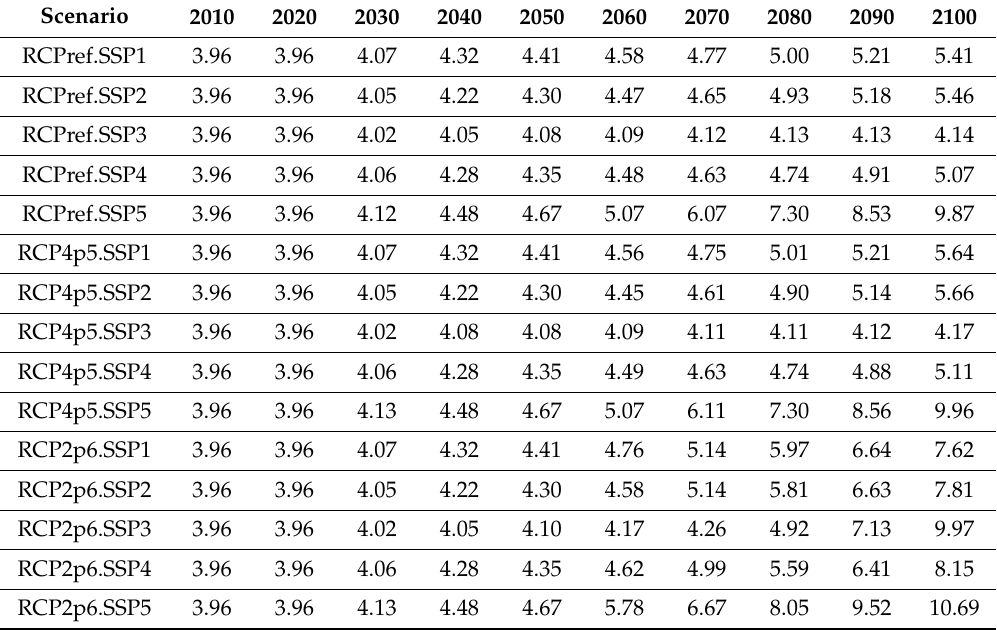
Table A23. Industrial roundwood harvest assortments—Pulpwood (millions of m 3 / year, under bark). Scenario